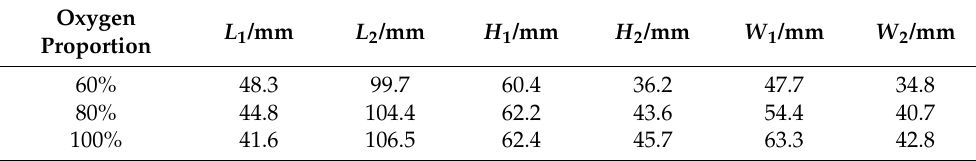
Figure 13. Shape and dimension of cavity (expanding foam).